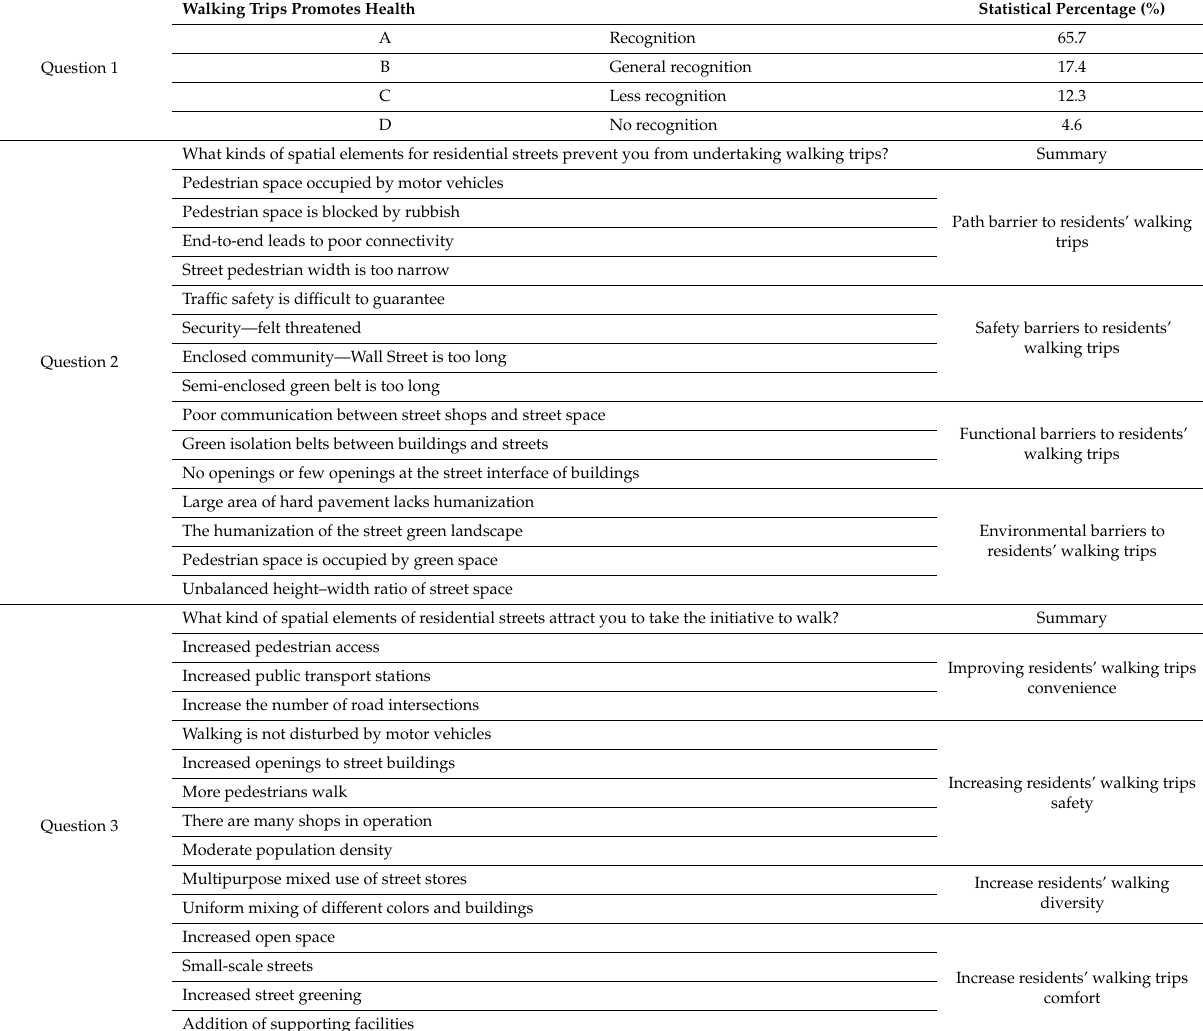
Table A2. Interview questionnaire and statistical summary of 375